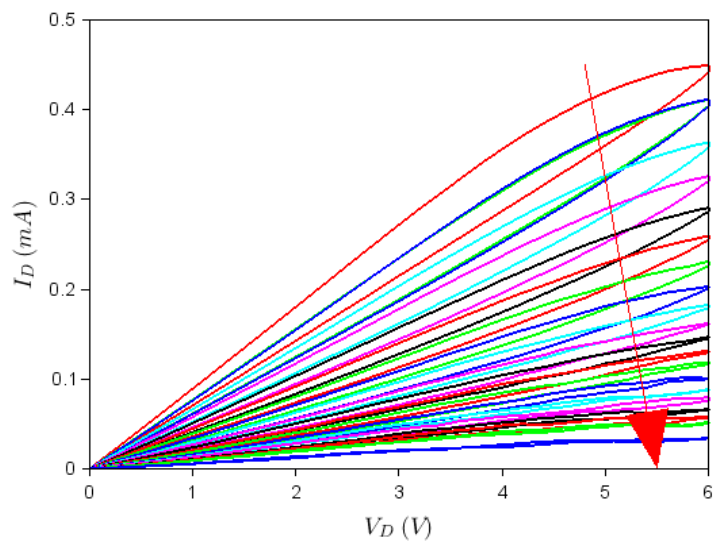
−= Figure 5. Dependence at V TG = − 6 V, V BG = 2 V, and di ff erent drain voltage sweeps. The arrow V V, V = 2 V, and different drain voltage sweeps. The arrow Figure 5. Dependence at 6 TG BG indicates the direction of increase of the sweep indicates the direction of increase of the sweep number.